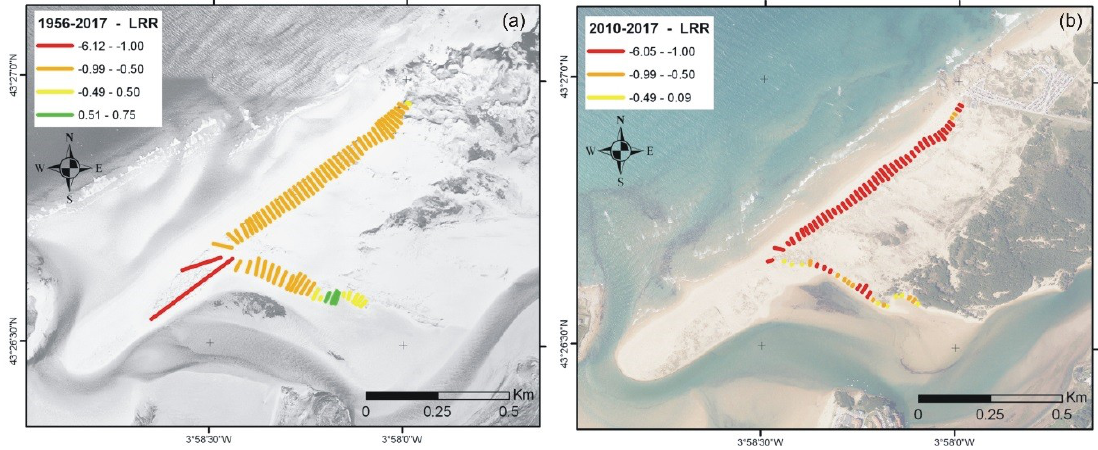
Figure 5. DSAS results for the Linear Regression Rate (LRR) statistical parameter (m year − 1 ) at the Liencres dune system, for the entire time period ( a ) and post-storm period ( b ).